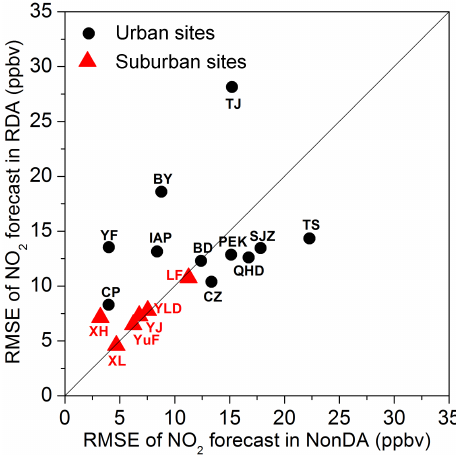
Figure 2. Comparison of the RMSE (ppbv) of 1h NO 2 forecasts at the 17 stations of Beijing and its surrounding areas during the pe- riod of 00:00 local time (LT) 9 August to 00:00LT, 23 August in 2008 in the RDA experiments and those in the reference (NonDA) experiment with a free run of the model. The comparisons at urban sites are denoted by the dots and those over suburban stations are represented by the triangles. The abbreviations of the station names are displayed close to the marks. The number of the valid observa- tions used for the calculation is 336 at QHD, SJZ, TS, IAP, LF, YF, and XH, and the numbers are 292, 226, 326, 317, 326, 320, 333, 321, 311, and 323 at BD, PEK, BY, CZ, CP, TJ, XL, YJ, YLD, and YuF,